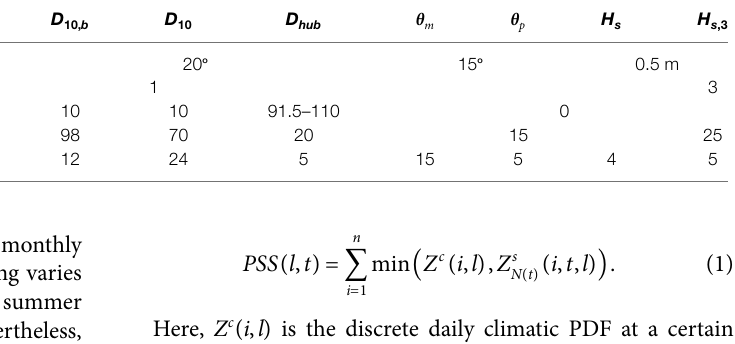
Frontiers in Energy Research |